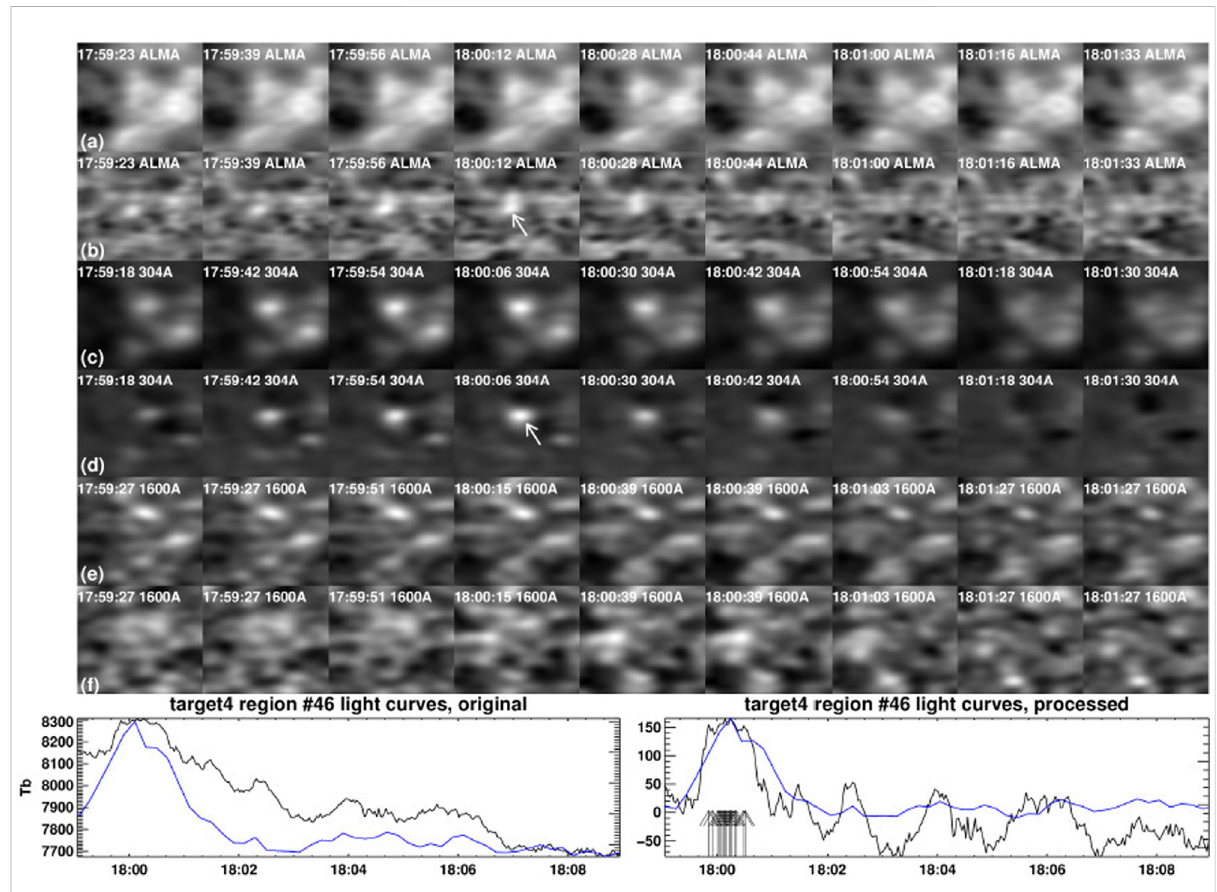
FIGURE 7 A quiet Sun transient event observed at 3 mm and 304 Å. Panel (A) shows characteristic ALMA snapshots while panel (B) shows the same snapshots after the average 3 mm image has been subtracted. Rows c – f: same as (A , B) but for the 304 (C , D) and the 1600 Å data (E , F) . The white arrows markthe transient brightening. The fi eldof view is35 ″ × 35 ″ . Bottom row: light curves of theevent emission at3 mm (black) and304 Å (blue) before and after processing (left and right panel, respectively) (from Nindos et al., 2020). Reproduced with permission ©